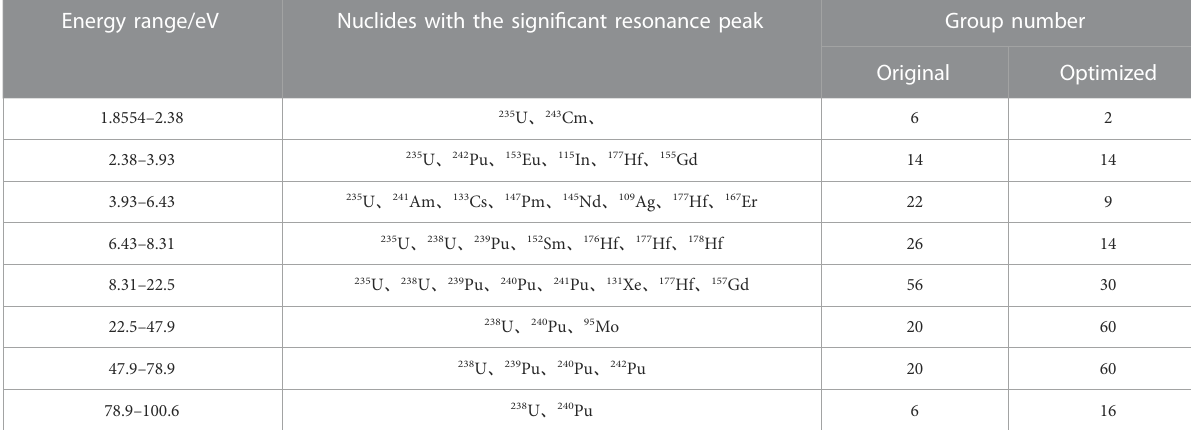
TABLE 2 Optimized group structure for the energy range of 1.8554 – 100 eV. Energy range/eV Nuclides with the signi fi cant resonance